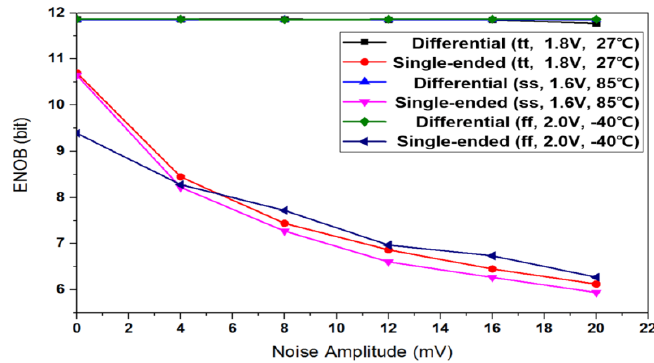
Figure 5. Spectrum analysis of successive approximation register (SAR) analog-to-digital converters (ADC) architectures with random noise.